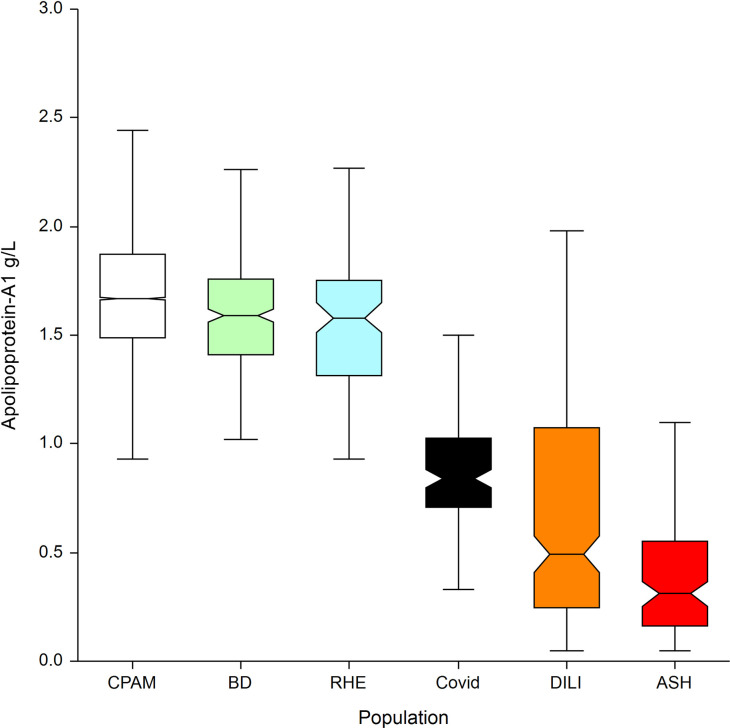
Apolipoprotein A1 median with IQR between the 6 populations.CPAM: general population assessing specificity of apolipoprotein-A1 in the sentinel context of use. Three populations were used for assessing higher risk of false positive: severe acute alcoholic hepatitis (ASH), drug induced liver disease (DILI), and rheumatologic disease (RHE). The blood donors population (BD) was at lower risk of false positive.